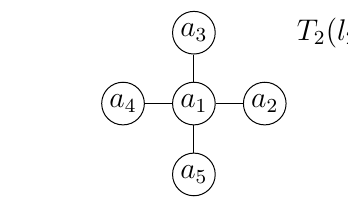
( l ) and the labeled star T 1 1